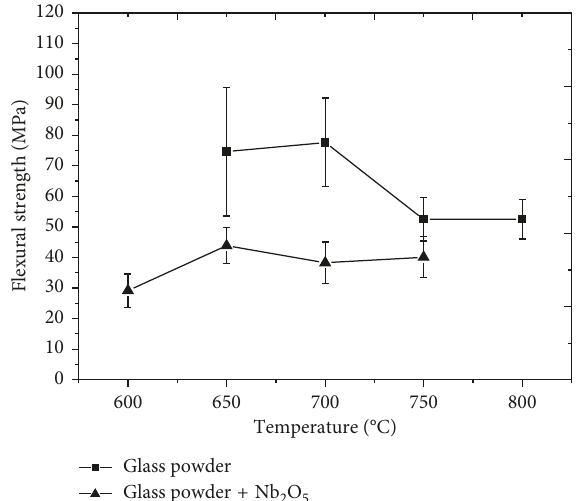
Figure 6: Flexural strength of all groups.